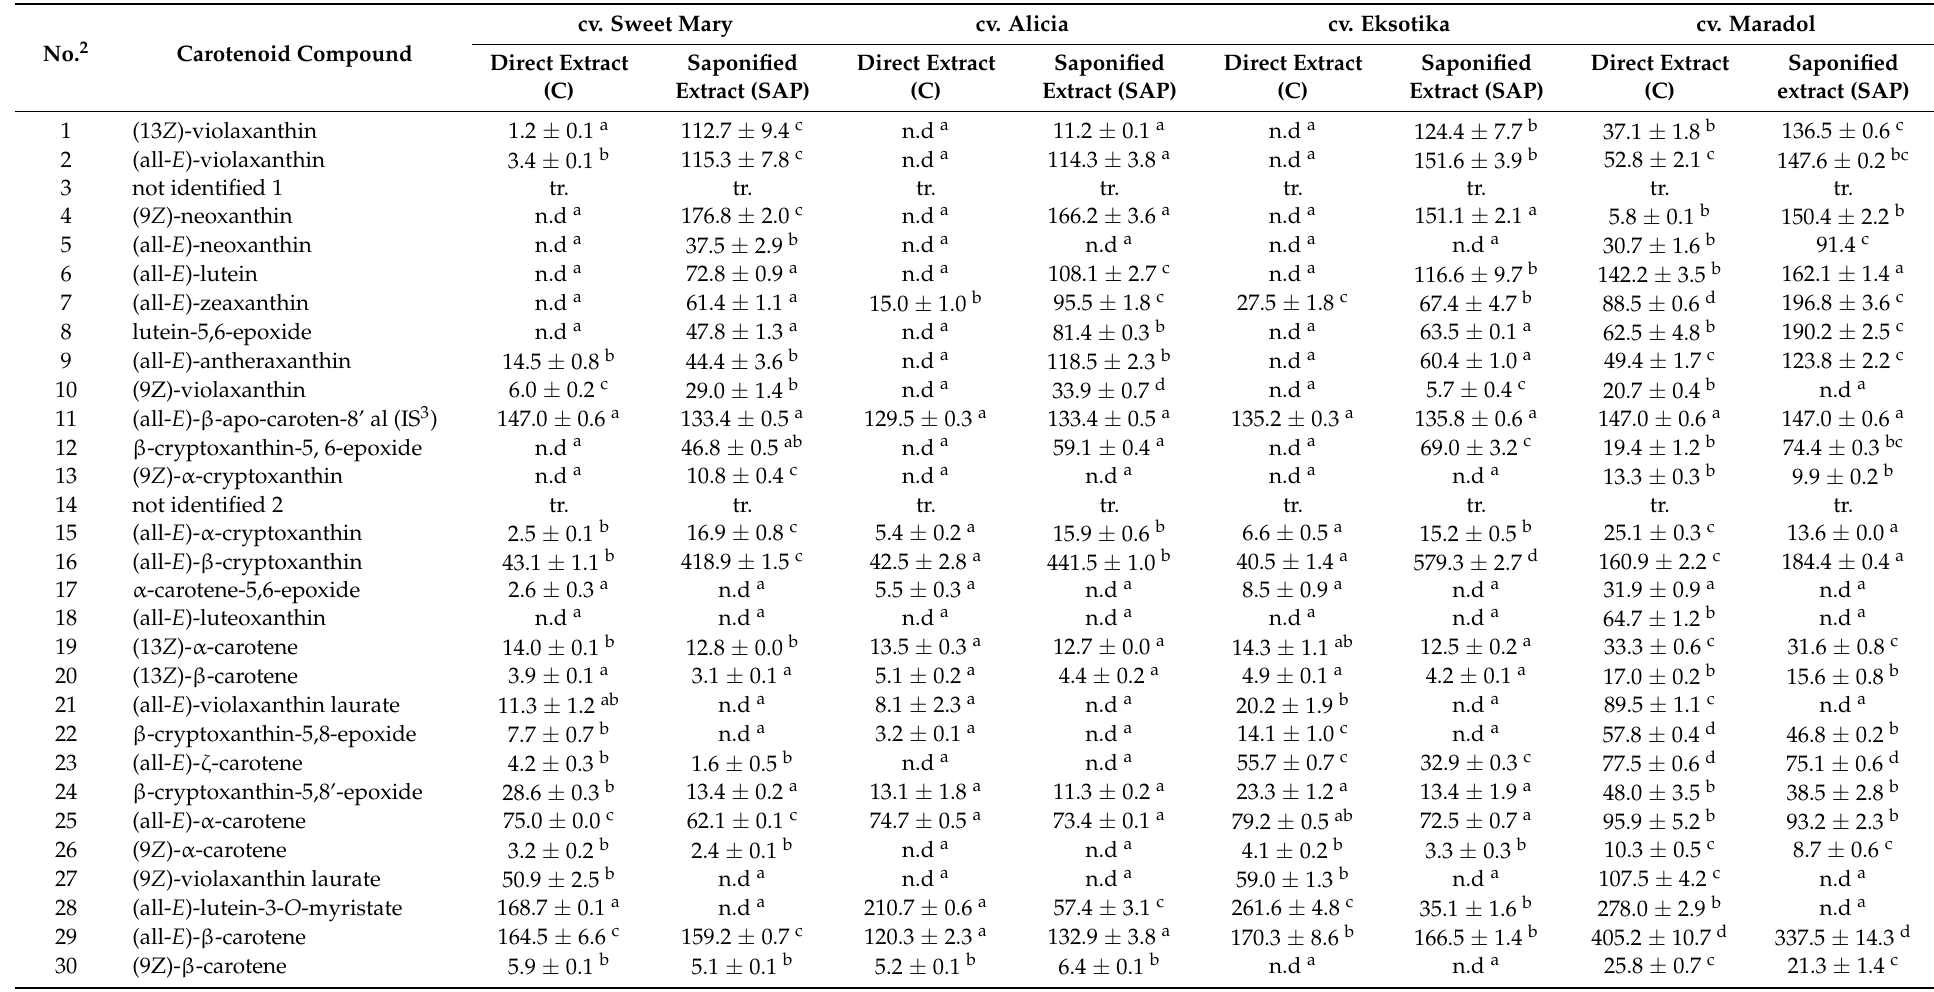
Table 3. Carotenoid content 1 ( µ g/100 g fresh weight) (mean ± standard deviation) and retinol activity equivalent (RAE) of direct and saponified extracts from papaya ( Carica papaya L.) pulps of Sweet Mary, Alicia, Eksotika, and Maradol